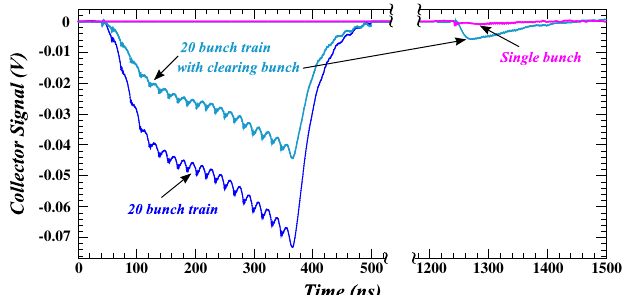
FIG. 6. Effect of an intermediate clearing bunch following about 900 ns after the end of a 20-bunch train for the case of 16-ns spacing. The difference in magnitude between the signals at 1250 ns is directly sensitive to the trapped electrons produced by the 20-bunch train.